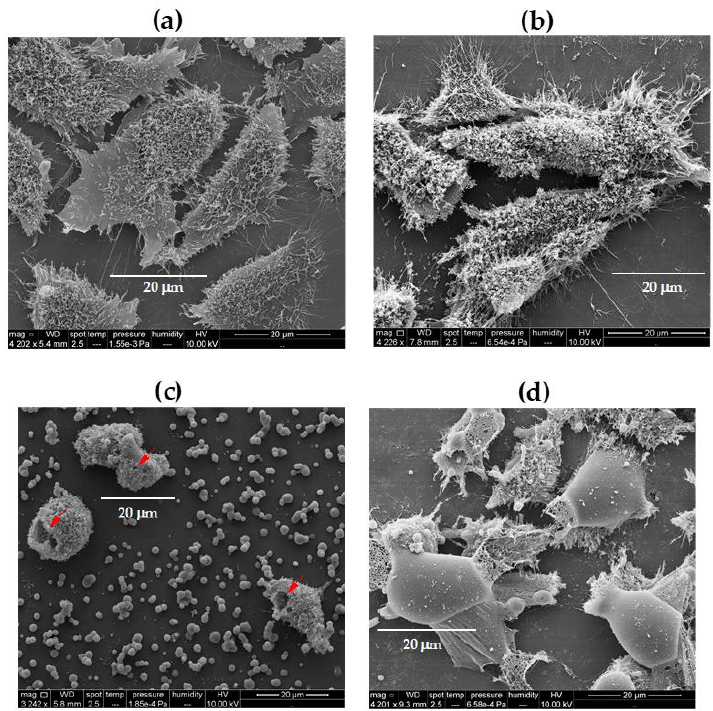
Figure 6. Scanning electron microscopy (SEM) of fibroblasts L929 incubated for 3 h with: ( a ) culture medium; ( b ) 0.01; ( c ) 0.1; ( d ) 1 mg · mL − 1 PDDA. The red arrows indicate holes on the cells at 0.1 mg · mL − 1 PDDA.